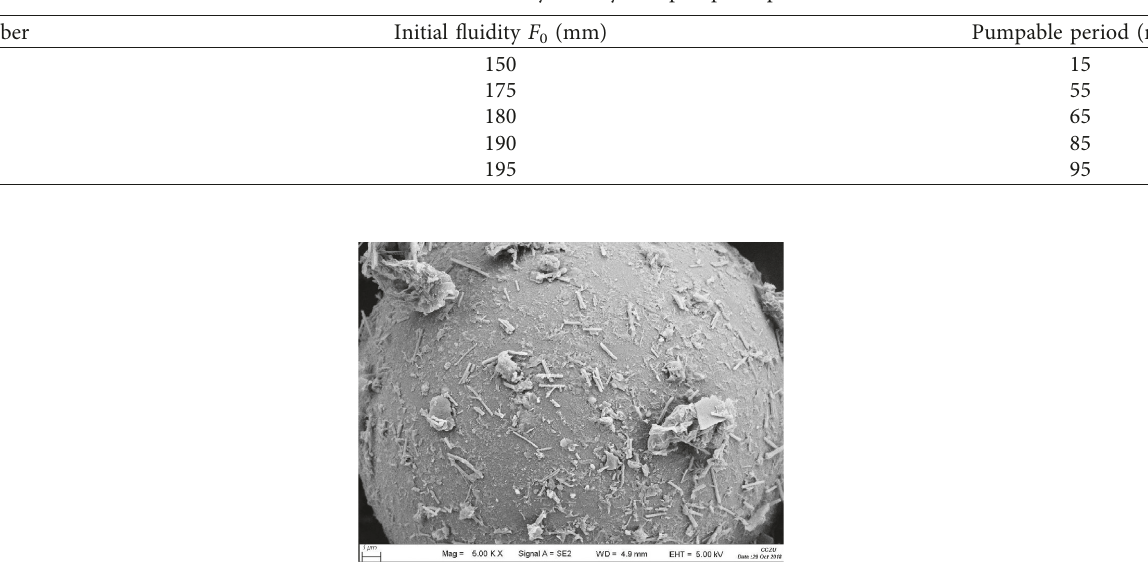
Figure 4: SEM image of bentonite slurry without PVA (no. A0 in Table 9, curing period � 7 days).